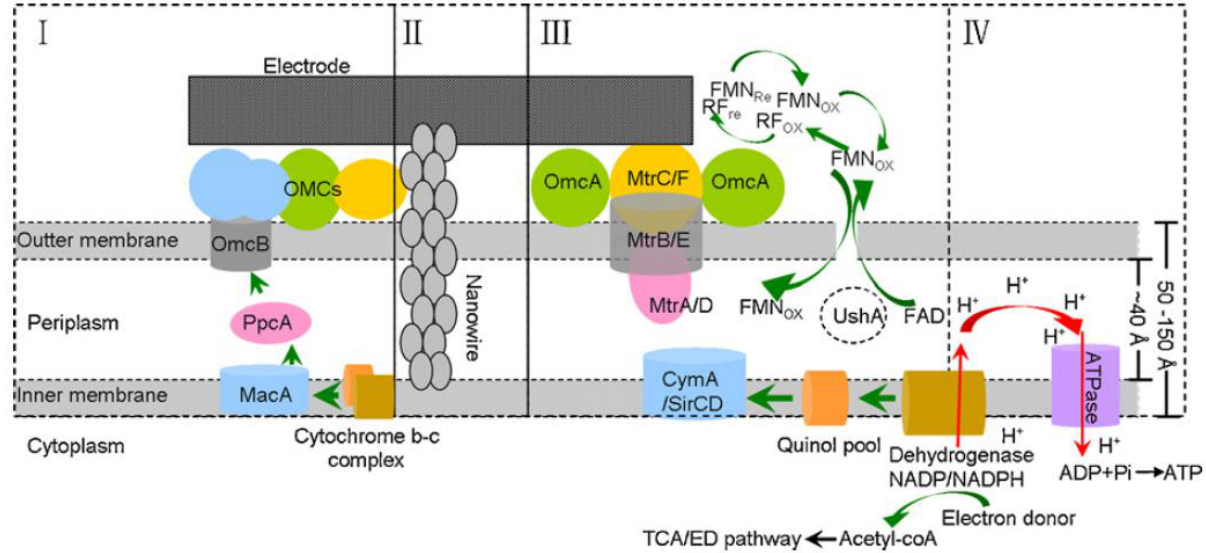
Figure 8. Extracellular electron transfer model of Geobacter and Shewanella. (I) The OMC-based direct electron transfer conduit in Geobacter; (II) bacterial nanowire; (III) electron transfer network of Shewanella including flavins and CTCs; (IV) electrode respiration-coupled proton motive force and energy (ATP) generation